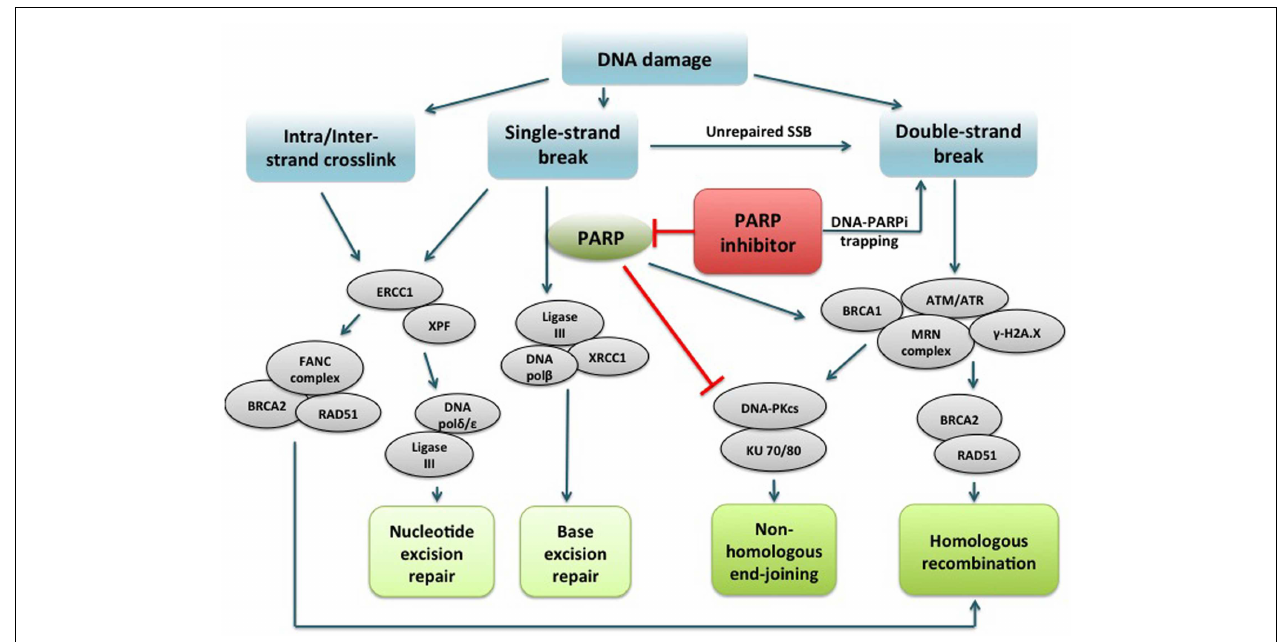
components of the DNA repair system, and whether defects in these repair pathways can confer sensitivity to PARPi are under investigation. PARP, poly(ADP-ribose) polymerase; PARPi, PARP inhibitor; DNA pol β / δ / ε , DNA polymerase beta/delta/epsilon; XRCC1, X-ray repair cross-complementing protein 1; DNA-PKcs, DNA-dependent protein kinase catalytic subunit; KU 70/80, a.k.a XRCC6/5 (X-ray repair cross-complementing protein 6/5); ATM, ataxia telangiectasia mutated; ATR, ataxia telangiectasia and Rad3-related; γ -H2A.X, gamma-histone H2A member X; RAD51, RAD51 homolog ( S. cerevisiae ); ERCC1, DNA excision repair protein ERCC1; XPF, DNA repair endonclease XPF (xeroderma pigmentosum group F-complementing protein); FANC, Fanconi